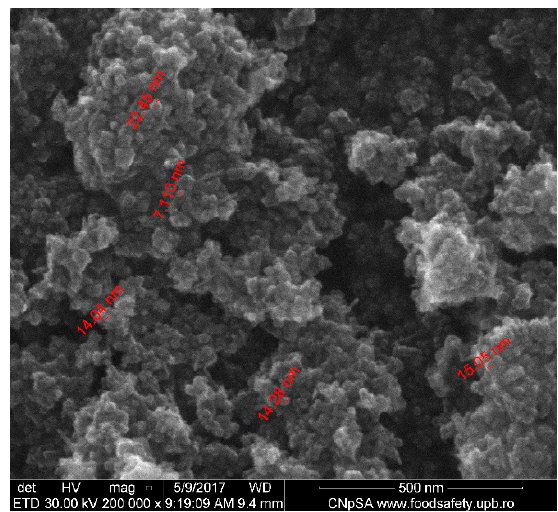
Figure 1. The SEM image of Fe 3 O 4 -PABA. The TEM image (Figure 2a) confirms the presence of nanoparticles, and that the size of the ferrite core is below 12 nm. The Selected Area Electron Diffraction (SAED) image (Figure 2b) proved the presence of the Fe 3 O 4 crystalline structure.